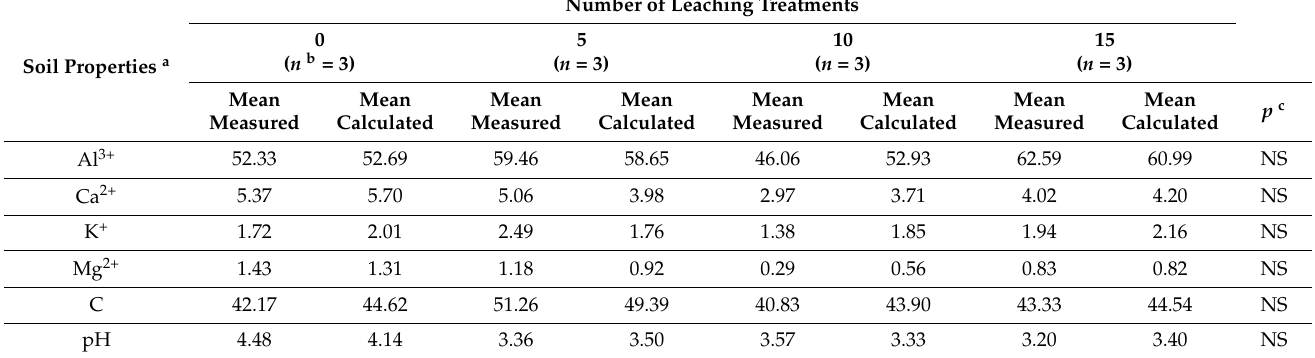
Table 4. NIR spectroscopy results for the validation of soils under fir stands (measured versus calculated values, p